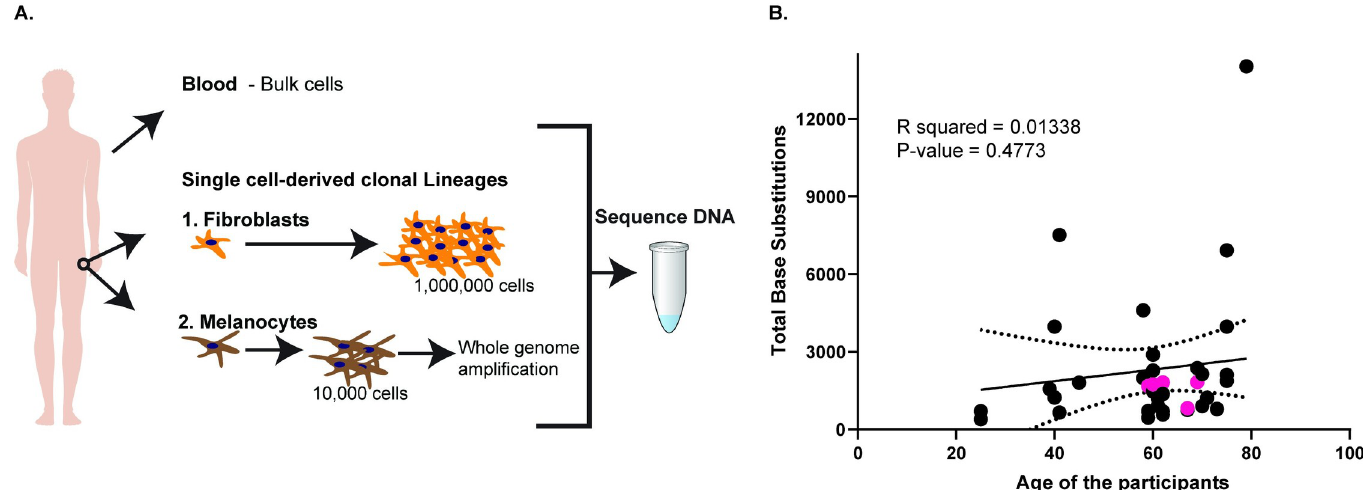
Fig 1. Schematics and total base substitutions identified per clonal lineage in this study. (A) Schematics of the study design. From each donor, we obtained blood for whole-genome sequencing. In addition, we obtained skin biopsies from the hips of the donors from which fibroblasts and melanocyte clonal lineages were obtained. Fibroblasts were grown up to a million cells and their DNA was directly used for whole-genome sequencing, while melanocytes grew up to 10,000 cells and the DNA was whole-genome amplified and thereafter sequenced. (B) The total base substitutions in each clonal lineage versus the age of the donors. The pink filled circles denote melanocyte clones. The x-axis denotes the ages of the donors, while the y-axis denotes the number of base substitutions. The solid black line is the linear regression line for the samples, while the dotted black curves are the 95% confidence intervals. The source data for this figure is in S1 and S2 Tables.